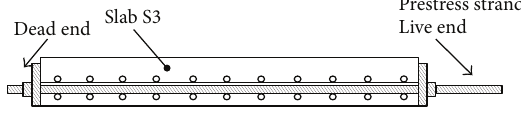
Figure 15: Dead and live end anchor.